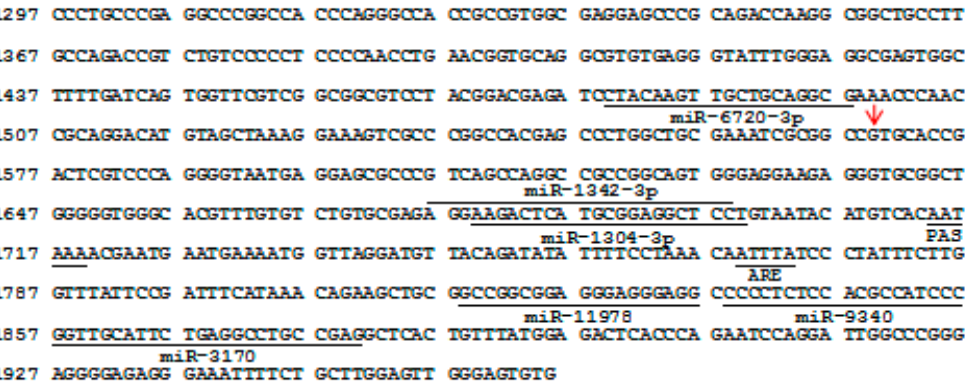
Figure 1. Characterization of the partial sequence of the 3’-untranslated region of the Large White pig bone morphogenetic protein 7 ( BMP7 ) gene. The transcription start codon was assumed as +1 (GenBank ID: XM_005673044.3). The underline indicates the regulatory elements. Red arrows indicate the mutation c.1569A>G.